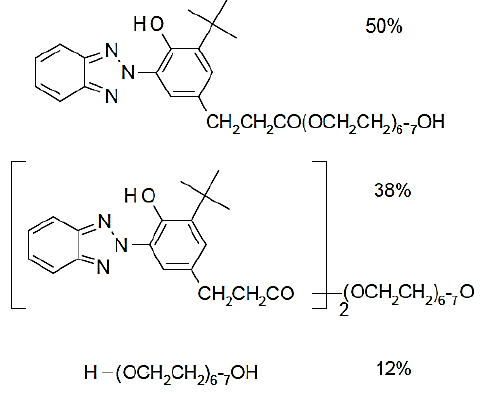
Figure 2. Chemical composition of Tinuvin 1130.